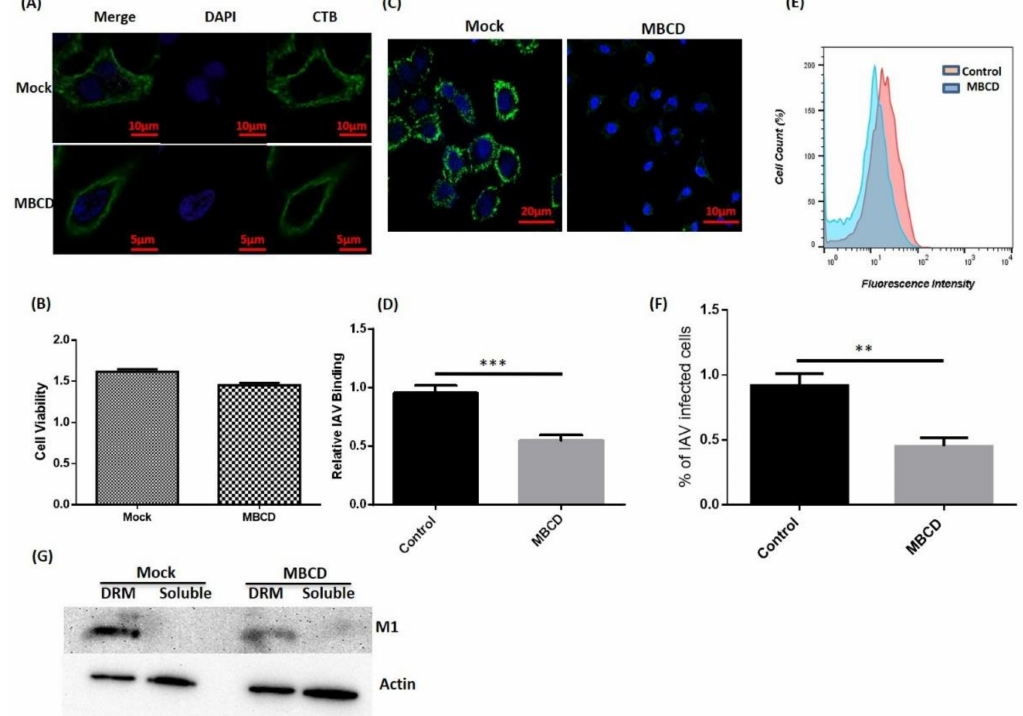
Figure 2. Disruption of host lipid rafts and IAV binding. ( A ) CTB-488 stained A549 cells (untreated and Methyl- β -Cyclodextrin (MBCD) treated). ( B ) Assessment of cell viability by MTT (3-4,5-Dimethylthiazol-2-yl)-2,5-Diphenyltetrazolium Bromide) assay. Error bars represent ± SD. ( C ) IAV incubated (4 ◦ C) A549 cells, ( D ) Relative IAV host binding represented as mean fluorescence intensity (FITC). *** p < 0.0002, calculated by student’s t -test. Error bars show ± SD. ( E , F ) Flow-cytometric analysis showing IAV host binding. The results are a representation of three independent experiments. ** p < 0.002, calculated by student’s t -test. Error bars show ± SD. ( G ) Isolation of lipid rafts as detergent-resistant membranes (DRM) and detection of IAV protein (M1). Actin served as internal